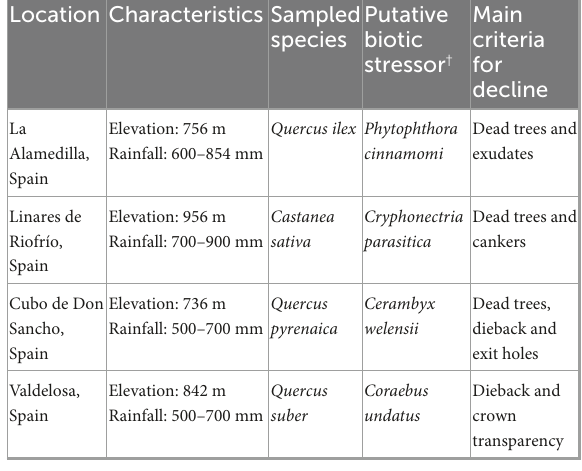
Putative species